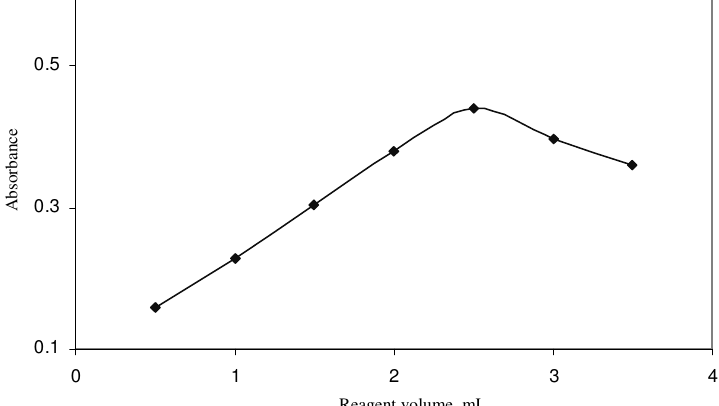
Figure 9. Effect of volume of 0.025% bromocresol green on the reaction of bromocresol green with 50 µ g mL -1